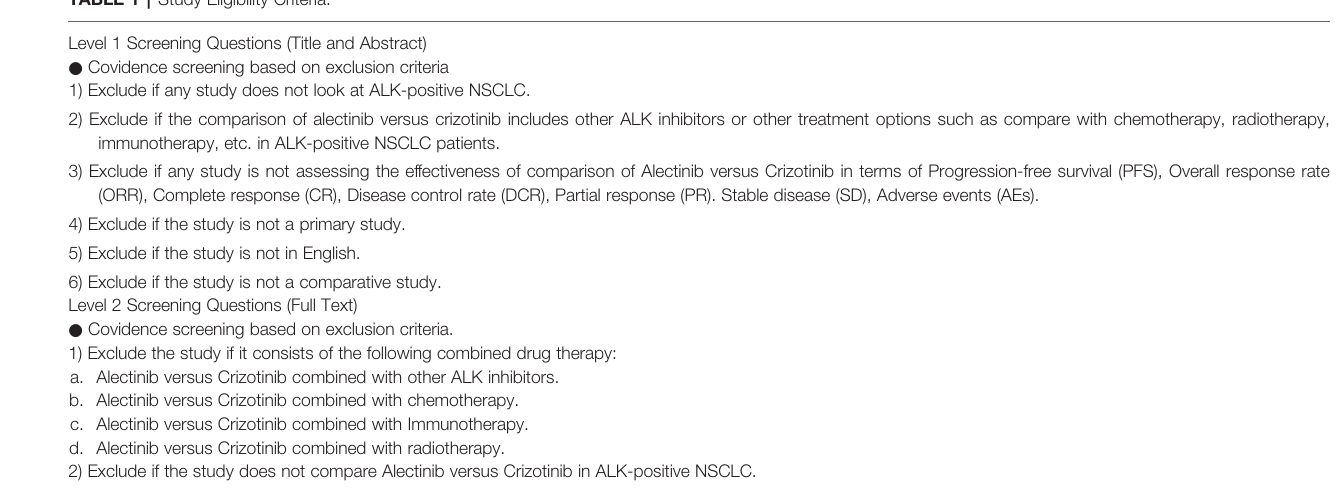
TABLE 1 | Study Eligibility